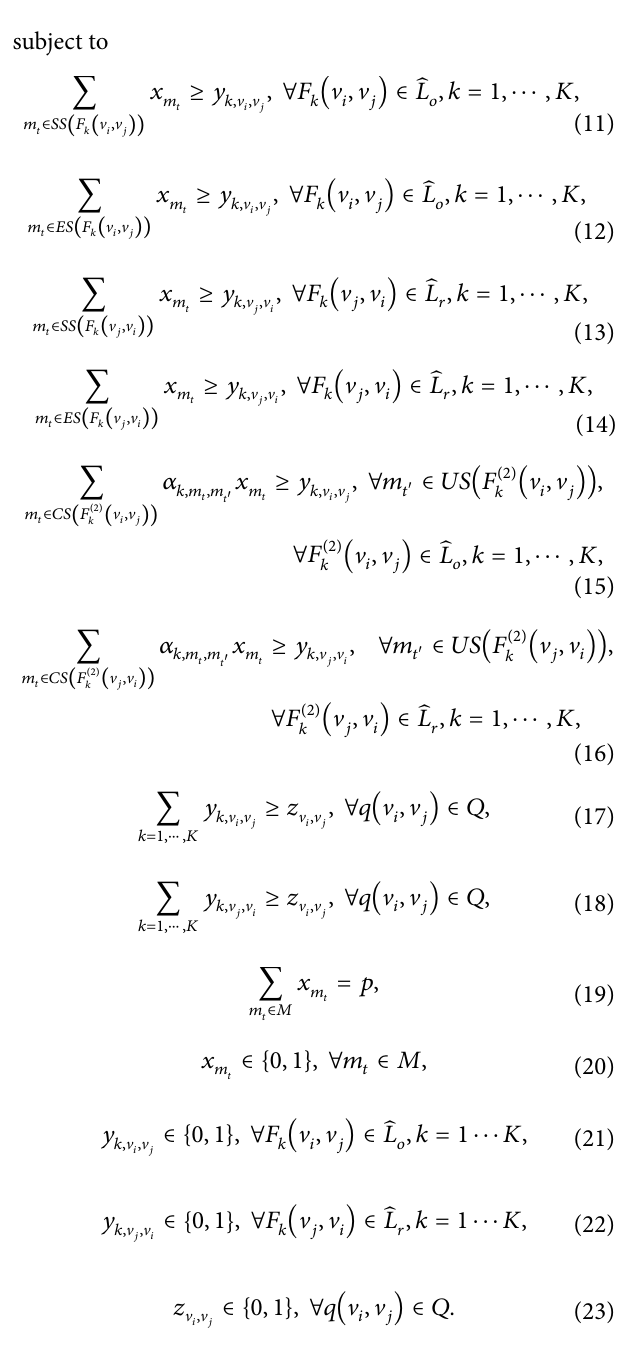
-th SNDF original 𝑘